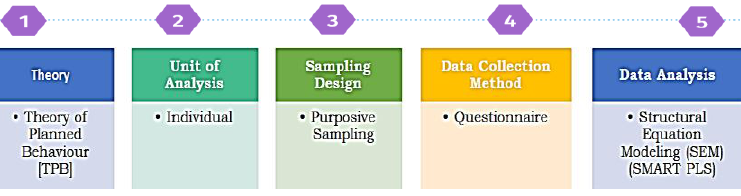
Figure 2. Research design.